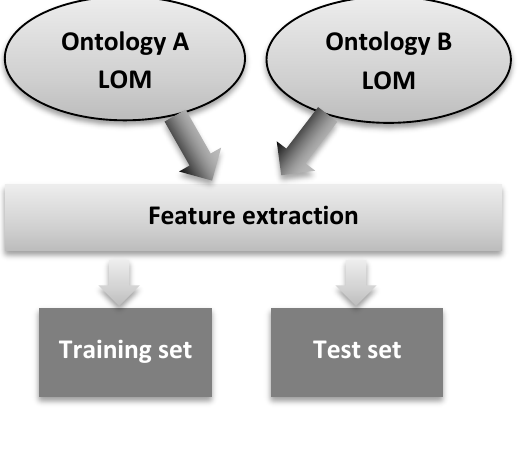
Figure 2. Illustration of the feature extraction process, and the obtaining of the Training and Testing